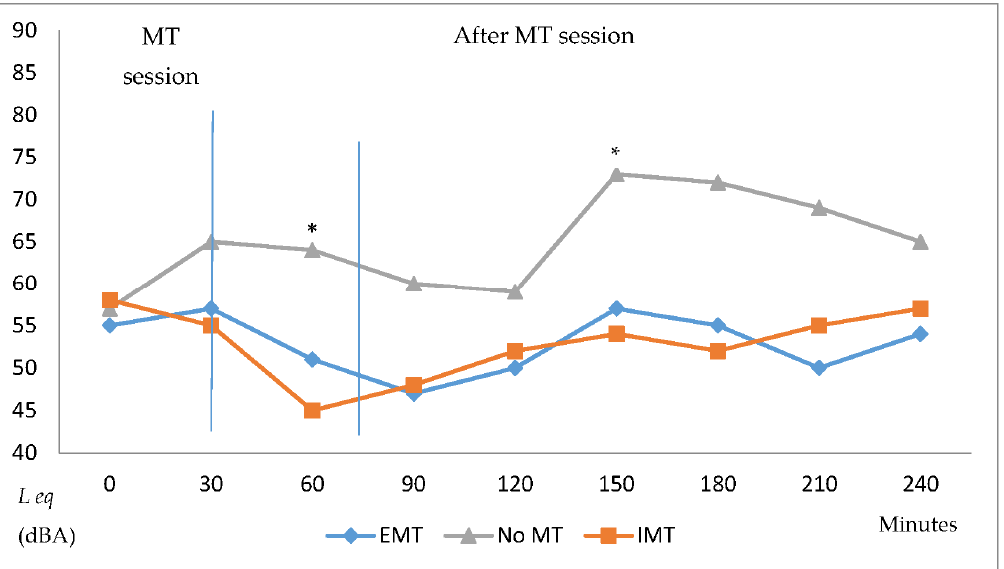
Figure 2. Leq for 4 h, during and after EMT, IMT, and no MT. Leq, approximate mean level of the fluctuating sound over a period; EMT, environmental music therapy; IMT, individual music therapy; MT, music therapy. * p < 0.05, compared to IMT and EMT.